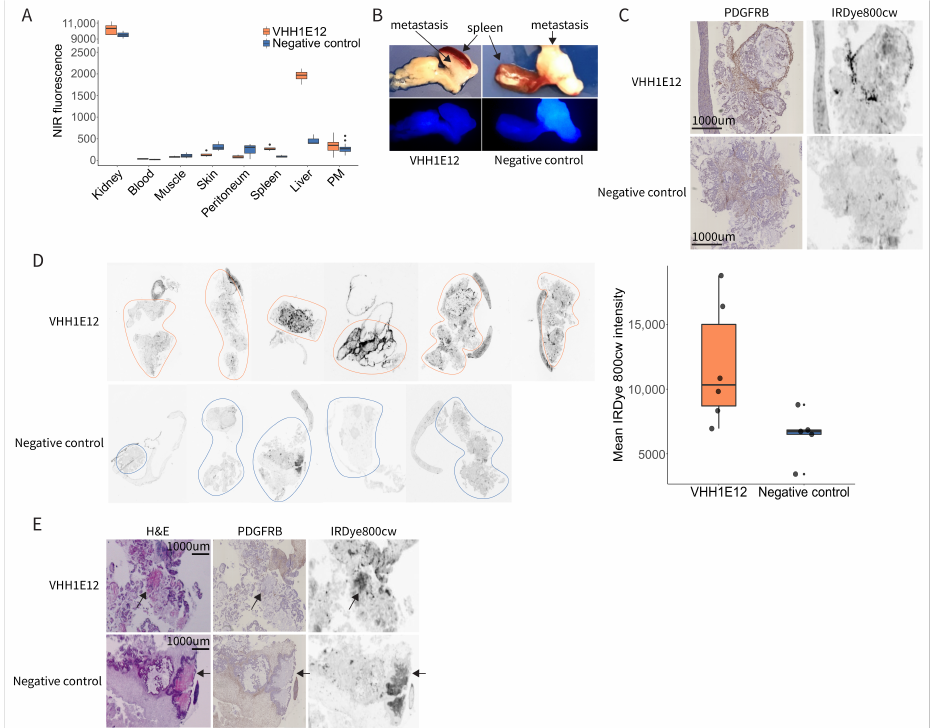
Figure 4. Detection of PDGFRB in experimental peritoneal metastases by IRDye-800CW-conjugated VHH1E12. ( A ) Quantification of near-infrared (NIR) signal of VHH1E12 and negative control in kidney, blood, muscle, skin, peritoneum, liver and peritoneal metastasis (PM). Whole organs and PMs were scanned in the Pearl NIR small animal imager. A same sized region of interest (ROI) was drawn in all the scanned organs and total fluorescence intensity was used. VHH1E12 n = 4 mice; negative control n = 3 mice. ( B ) Representative NIR scan of peritoneal metastasis uptake between VHH1E12 and the negative control on a whole tumour level. ( C ) PM tissue sections stained for PDGFRB using immunohistochemistry and scanned for IRDye800cw signal in the Typhoon scanner. ( D ) Left panel: PM tissue sections scanned for IRDye800cw signal in the Typhoon scanner. VHH1E12 n = 4 mice and n = 6 PMs; negative control n = 3 mice and n = 5 PMs. ROIs are drawn around the tumour tissue. Right panel: quantification of IRDye800cw in PM tissue sections. Mean pixel intensity is plotted for VHH1E12 n = 6 PM and negative control n = 5 PM. ( E ) Sequential PM tissue sections stained with haematoxylin and eosin showing areas of necrosis with strong eosin staining, indicated by the black arrows. These areas were negative for PDGFRB and showed a strong IRDye800cw